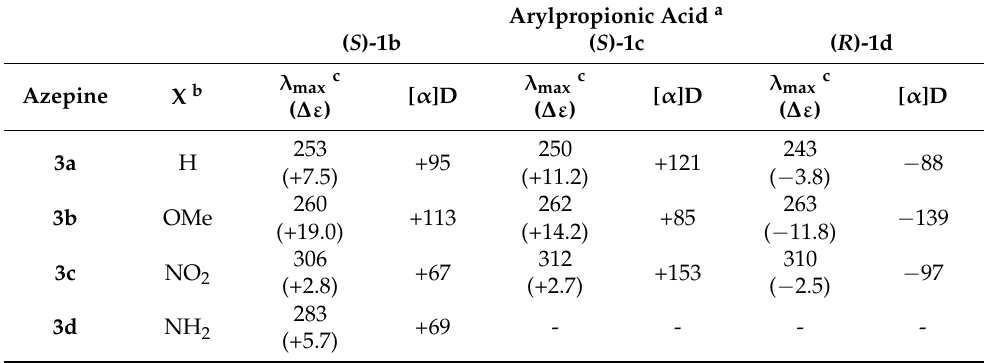
Table 1. ECD and [ α ] D data of biphenylamides derived from ( S )- 1b , ( S )- 1c and ( R )- 1d .